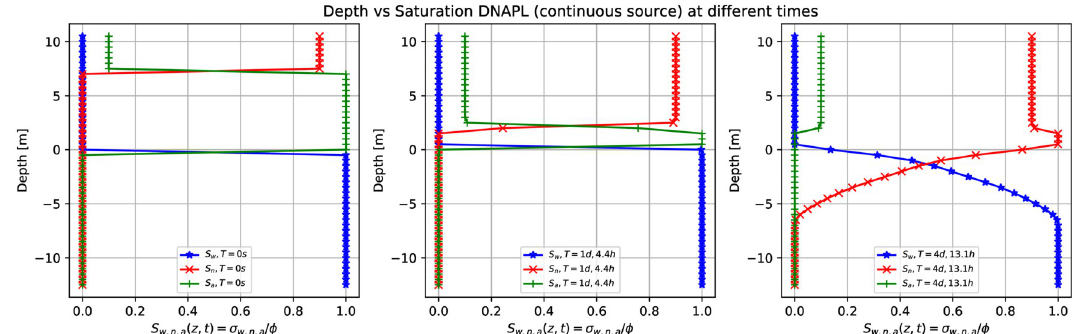
Fig 6. Depth vs. saturation of DNAPL (continuous source) at different times. Three-dimensional numerical simulation results of the depth as a function of the water saturation S w (blue points), DNAPL saturation S n (red points), and air saturation S a (green points) at various times for a continuous leak of DNAPL in Fig 5. Initially, at t = 0 s, a front of contaminant saturation is situated on top of the grid, which rapidly goes to zero. At the same time, it is filled by the air saturation (green point) in the unsaturated zone and water saturation in the saturated one. Notice how the sum of the three-phase saturations is always one. For later times the contaminant (red points) is immersed into the saturated zone.